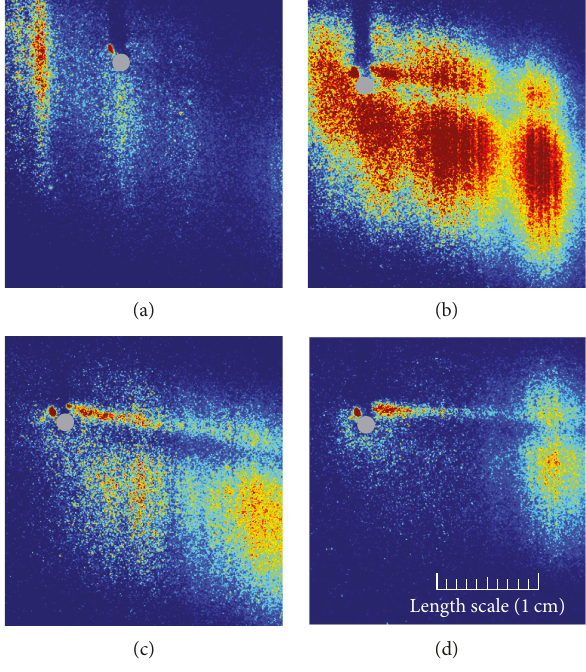
Figure 2: Spanwise scan of laser sheet. The diameter =2mm, sheet positions were 1, 2.5, 4, and 4.5 mm from the fl at, Reynolds number =70, and frame rate =100 Hz. The jet direction was at an angle of 90 ° to the surface of the fl at.